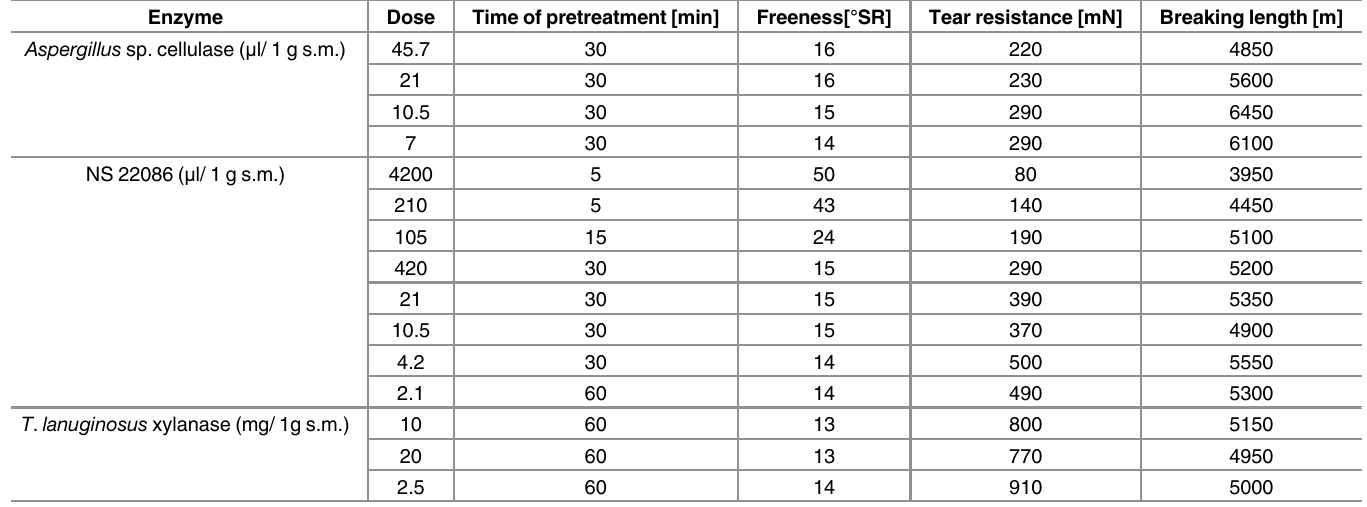
Table 2. The impact of the dose of enzymatic preparation and pretreatment time on the selected pulp and paper properties. Enzyme Dose Time of pretreatment [min] Aspergillus sp. cellulase ( μ l/ 1 g s.m.)